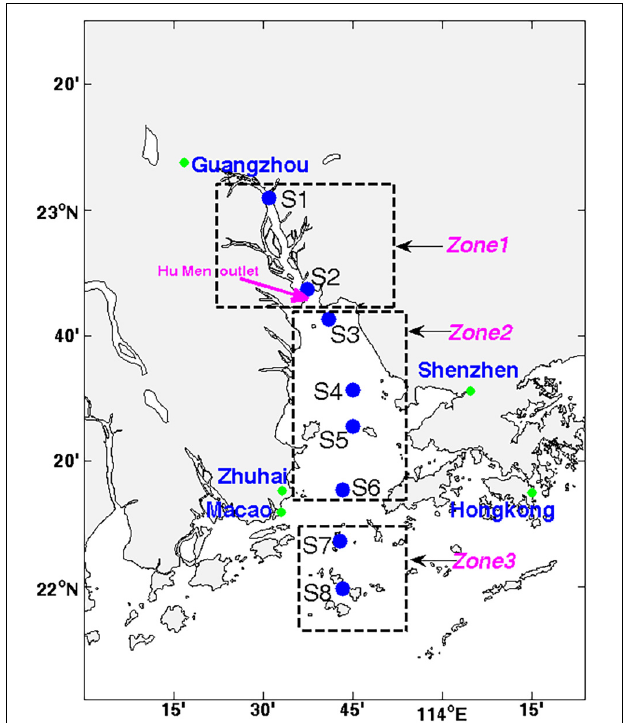
FIGURE 1 | Sampling stations of the Pearl River